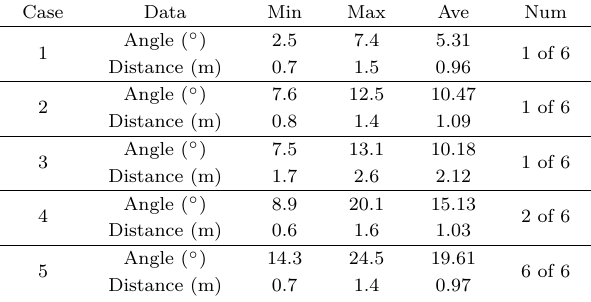
Fig. 11 Large angles cause difficulties in finding foreground correspondences and finding good seams to blend aligned foreground